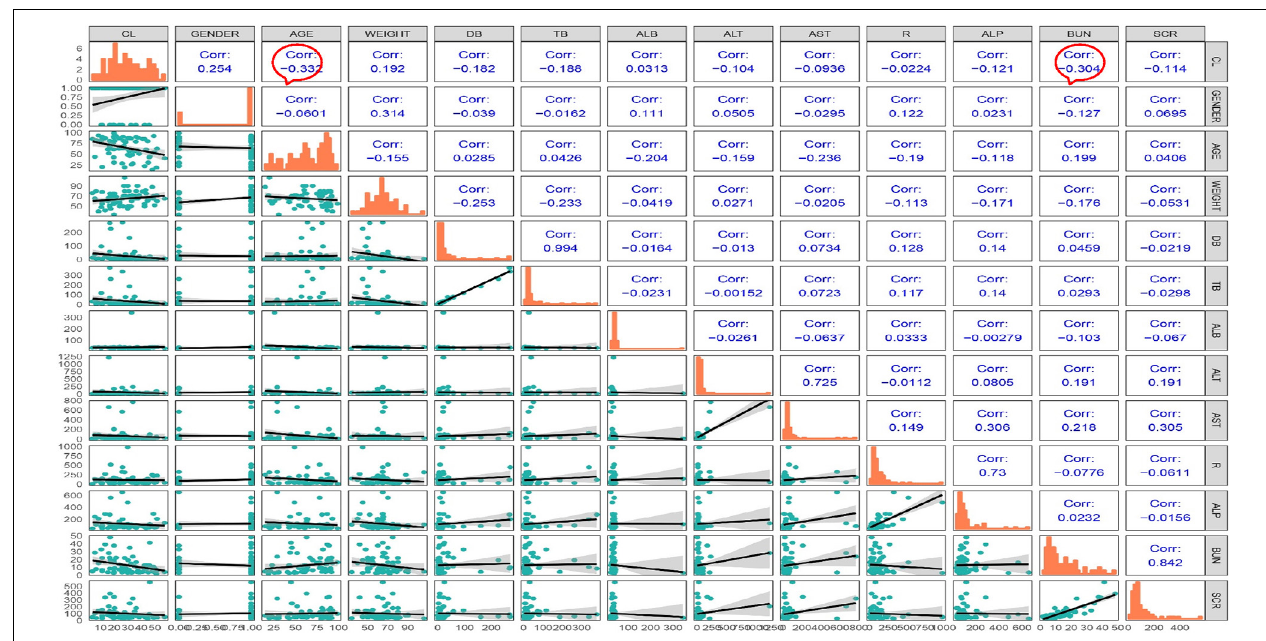
FIGURE 4 | Matrix diagram of the covariates.